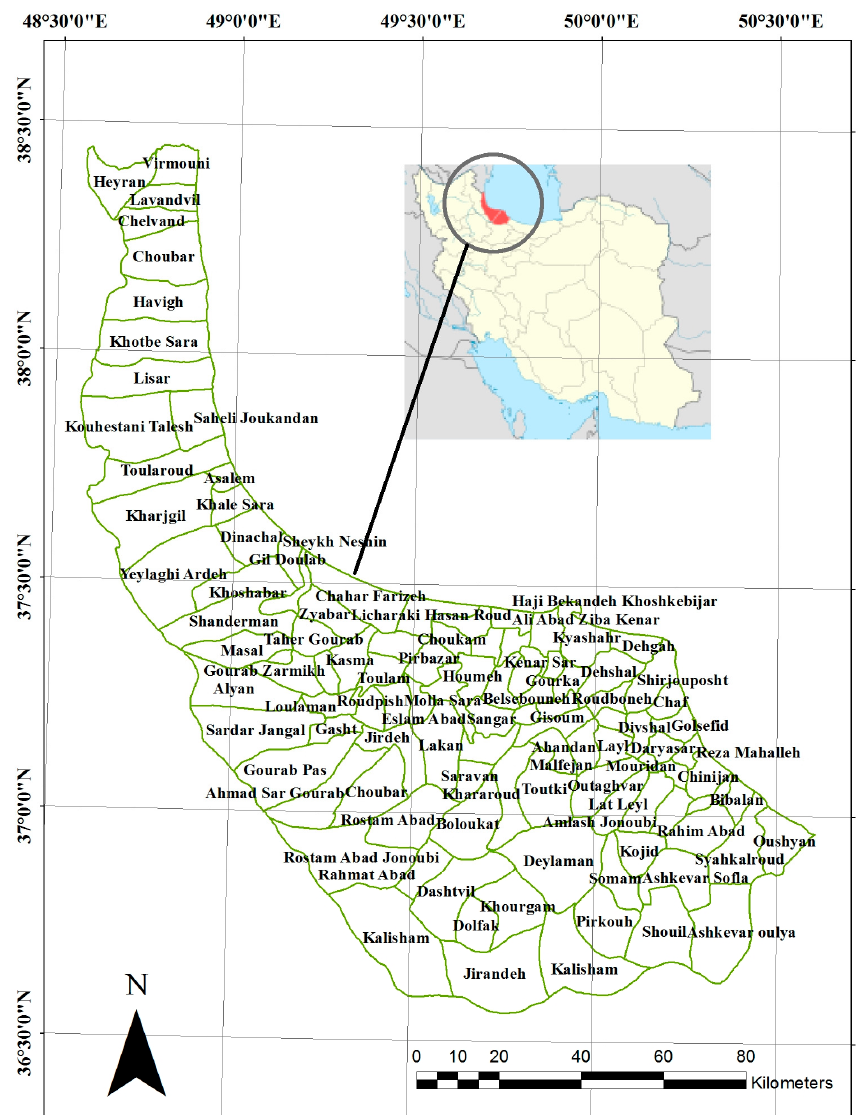
Figure 1. Boundary of Gilan and rural districts.